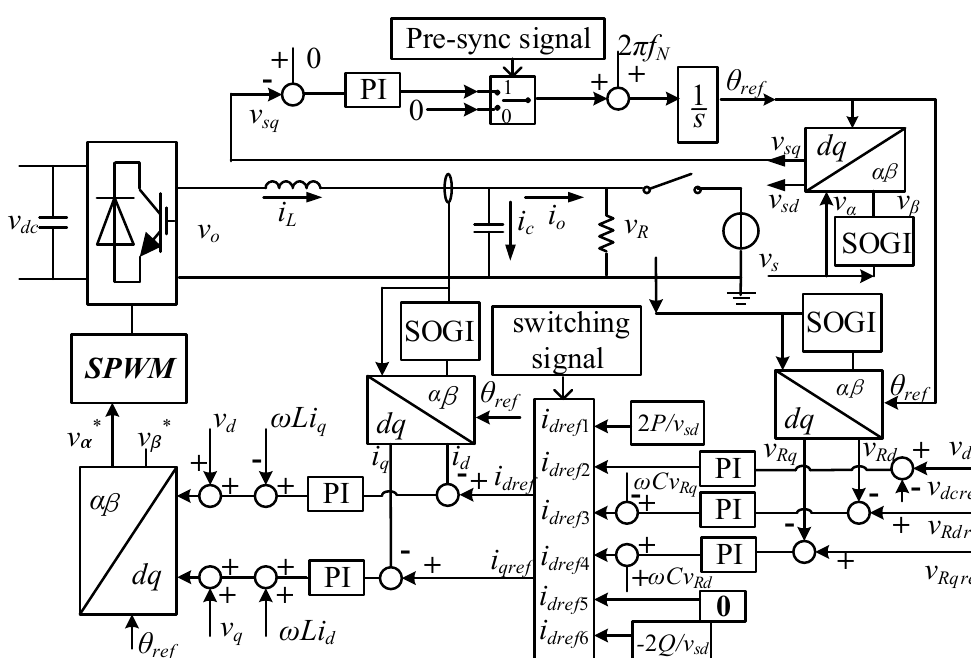
Figure 7. Block diagram of the overall control strategy for a single-phase DC/AC bidirectional converter.